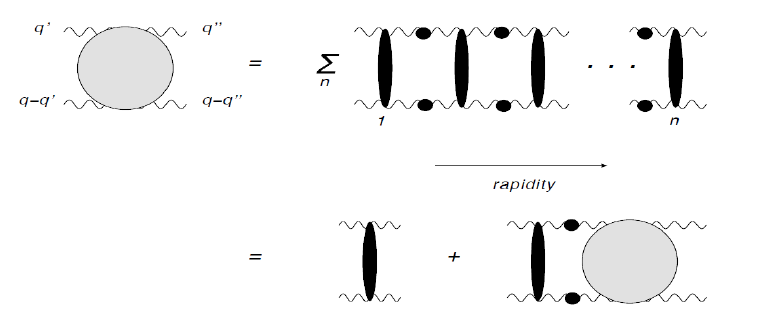
Fig. 1. BFKL Ladder. Wavy line are reggeized gluon and internal straight-line elementary